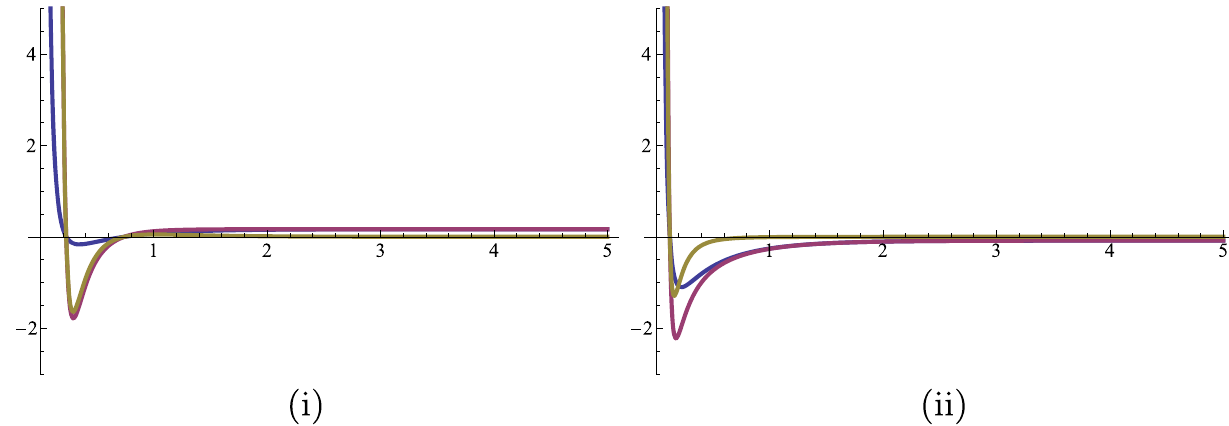
ity. (ii) dS-type solution: K = 1 . 5, Q = 1, R 0 = 1, L null = 0 . 2.